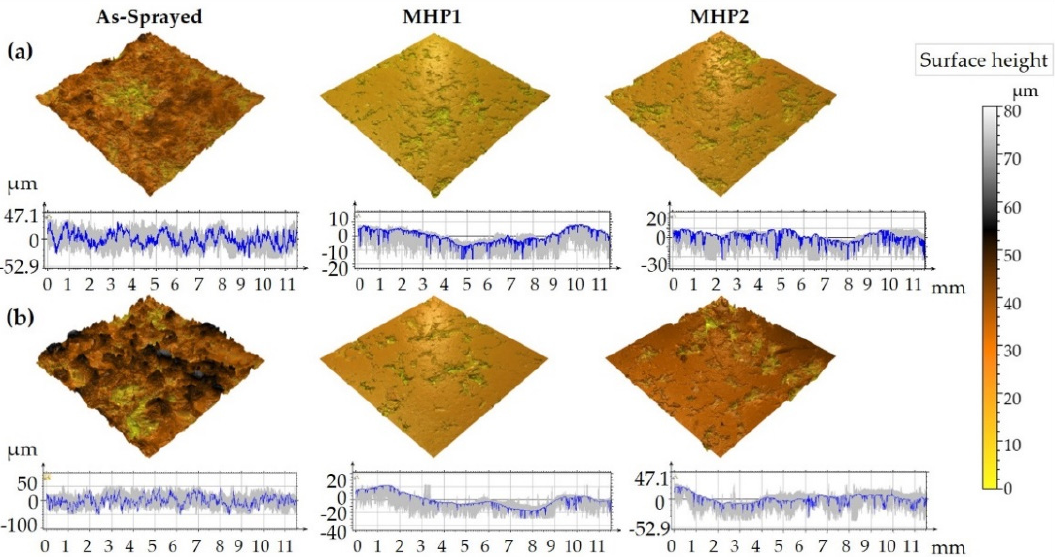
Figure 11. Surface roughness of the as-sprayed condition and after the MHP-treatment: ( a ) com- pressed air sprayed coating (CA2) and ( b ) argon sprayed coating (A2).